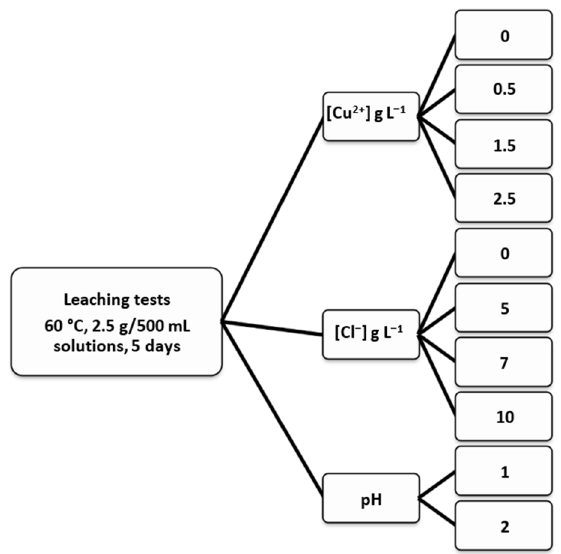
Figure 2. Summary of the leaching tests and parameters investigated.